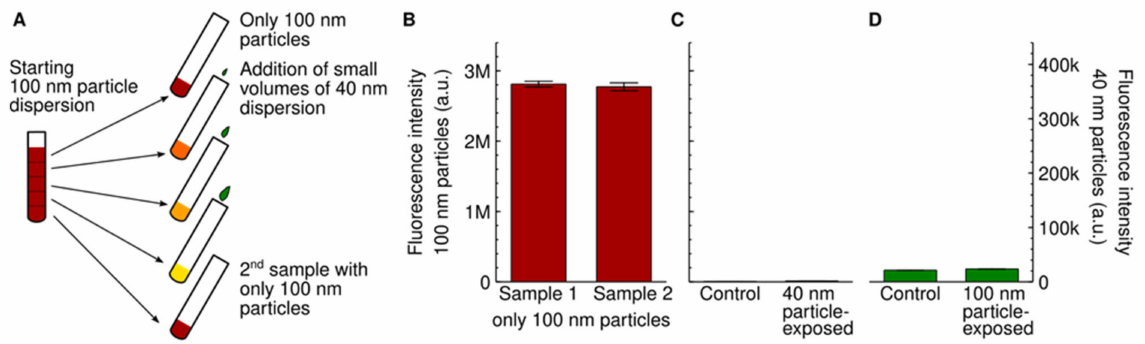
Figure 1. Experimental setup. ( A ) Schematic showing the dispersion procedure we used to ensure that the concentration of the 100 nm particles was the same for all samples. A first dispersion of the 100 nm particles was prepared and then divided up. To the resulting samples, different small volumes of a 40 nm particle dispersion were added. The first and last sample were left without 40 nm particles to serve as controls. Note that the colours are schematic only. For the experiments where we investigated the effect of competing 100 nm particles on the uptake of the 40 nm particles (Figures 4, S4 and S5), the role of the two particles should be reversed. See Methods for further details. ( B ) Nanoparticle fluorescence of cells exposed to the two different control dispersions of the 100 nm particles mentioned in panel A (first and last sample; 20 µ g/mL or 0.060 nM). The similarity of the signal is consistent with the two control samples having the same nanoparticle concentration. ( C , D ) Lack of cross-talk between the two particle signals. ( C ) Cells were exposed to only the 40 nm particles (100 µ g/mL; 4.7 nM) and the fluorescence intensity measured at the same wavelengths where we measured the 100 nm particles (left axis). There is a low background signal (right bar), but this is comparable to control cells not exposed to any particles at all (left bar). Note that the scale has been set to be relevant for the later results (Figure 2A and Figures S2 and S3). ( D ) Cells were exposed to only the 100 nm particles (80 µ g/mL; 0.24 nM) and the fluorescence intensity measured at the same wavelengths where we measure the 40 nm particles (right axis). There is a low background signal (right bar), but this is comparable to control cells not exposed to any particles at all (left bar). Note that the scale has been set to be relevant for the later results (Figure 4A and Figure S4). Overall, the results show that the contribution of one of the nanoparticles to the fluorescence when the other nanoparticle is measured is similar to control cells. For panels ( B – D ), results are presented as the mean ± its standard error over three